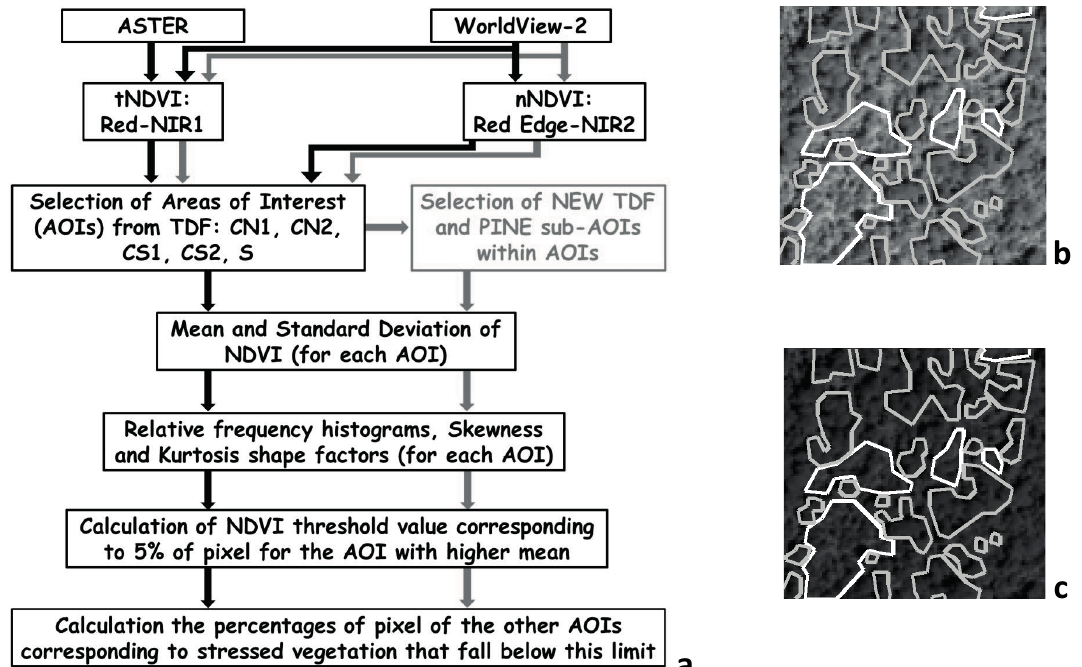
Fig. 2 (a) Flow chart of the procedure developed for AOIs (black pathway) and for sub-AOIs (grey pathway). (b) NEW TDF (white) and PINE (grey) Sub-AOIs examples for CN1 (highest pine tree density) NIR1-RE-RED band combination. (c) NEW TDF (white) and PINE (grey) Sub-AOIs examples for CN1 whit NIR1-GREEN-BLUE b and